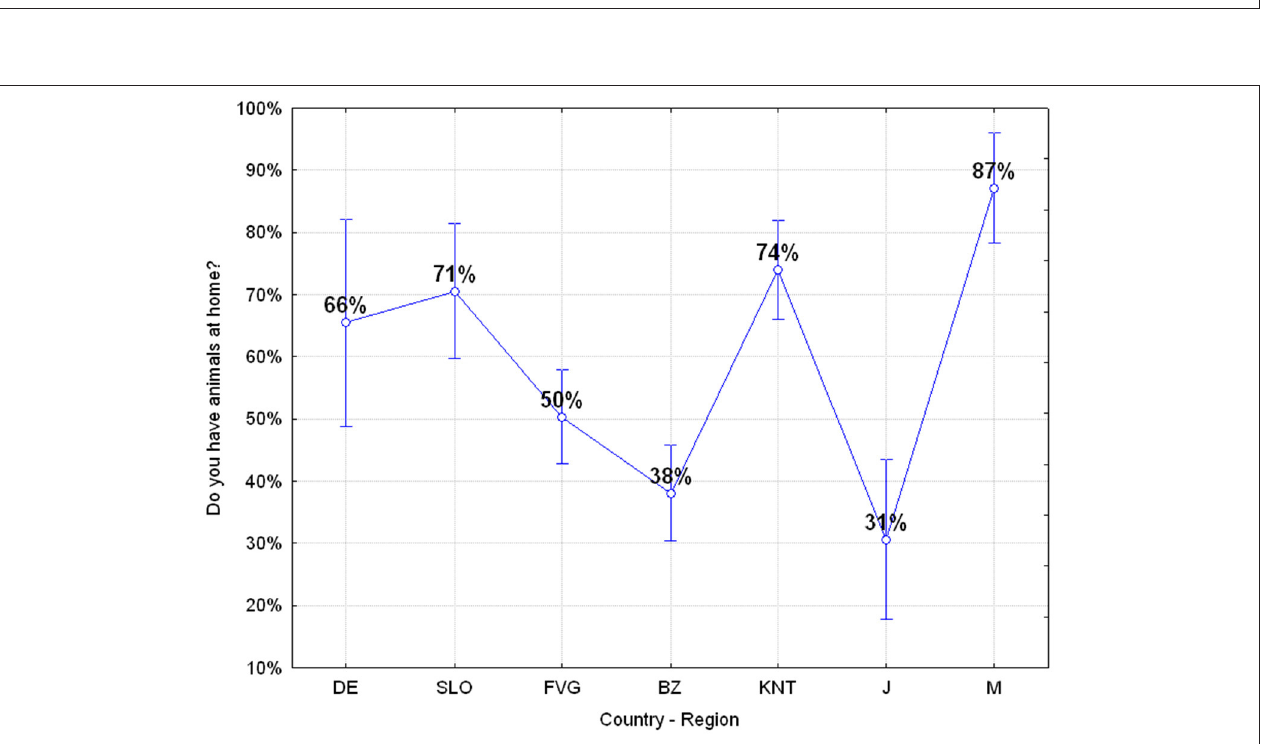
FIGURE 5 | Q2: “Do you have an animal at home?” ANOVA F (6,644) p = 0.00000 [Axes X regions or countries, Axes Y % correct answers–DE, Germany; SLO, Slovenia; FVG, Friuli Venezia Giulia Italy; BZ, Autonomous Province of Bolzano Italy; KNT, Carinthia Austria; J, Japan; M, Mauritius–( n = 656)].